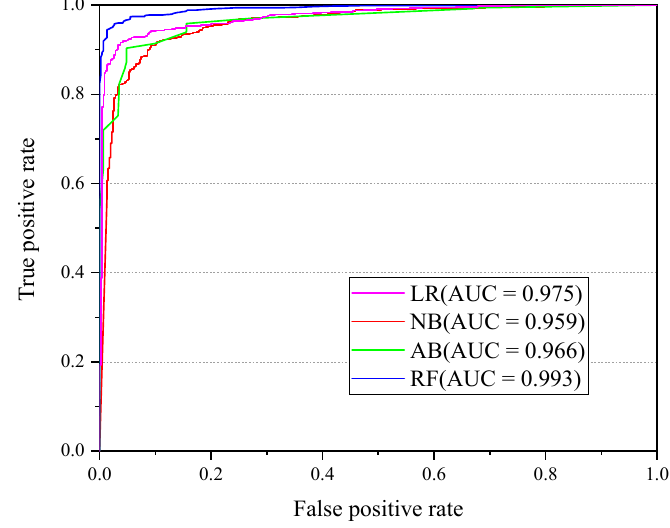
Figure 3. The ROC (Receiver Operating Characteristic) curves of the four models.